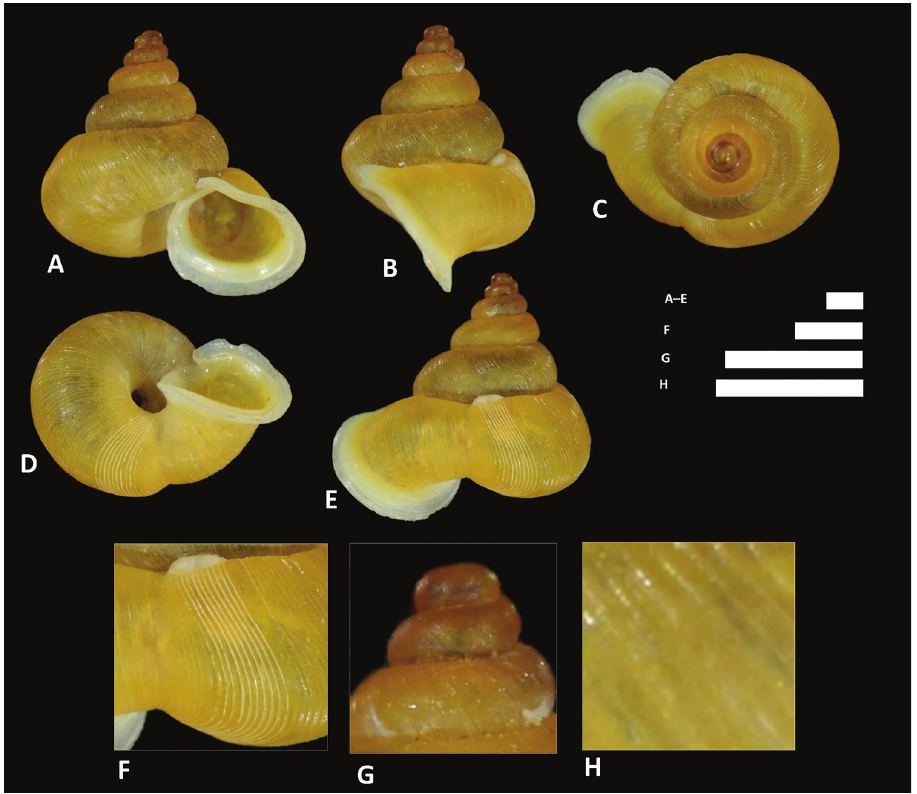
Figure 9. Alycaeus altispirus (Möllendorff, 1902) A–E Shell of lectotype, SMF 109738 F–H Close up of shell of lectotype, SMF 109738. Scale bars: A–G 1 mm; H 0.5 mm. All photographs by Páll-Gergely Barna, courtesy of R. Janssen,